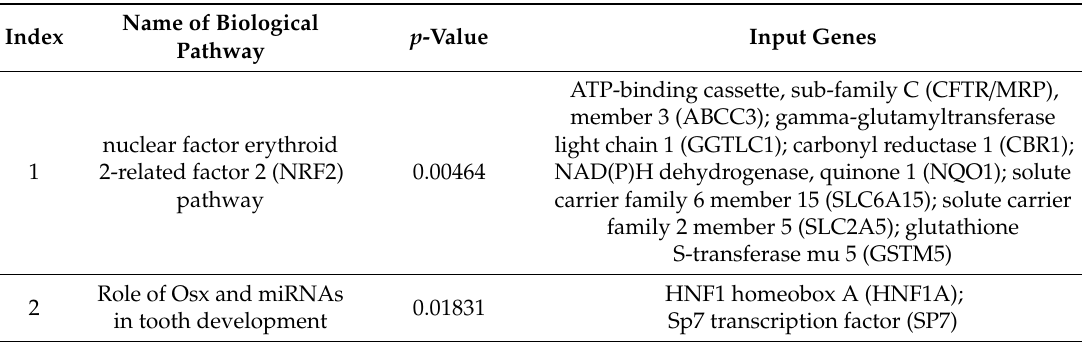
Table 4. Top 10 biological pathways associated with di ff erentially expressed genes after 3 nM